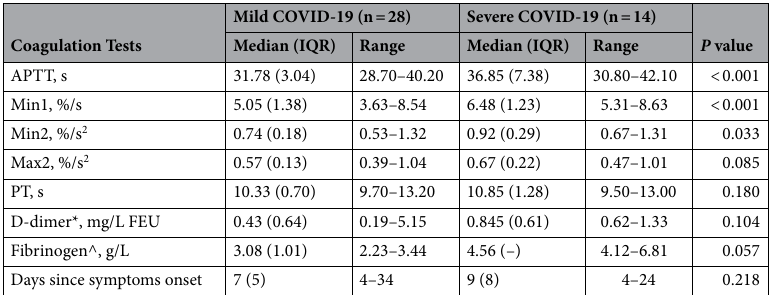
Table 3. Inter-individual comparison of coagulation data (PT, aPTT and aPTT-based clot waveform analysis profiles) between patients with mild COVID-19^ and severe COVID-19 # . * D-dimer results were only available in 11 and 4 patients with mild and severe COVID-19, respectively. ** Fibrinogen results were only available in 4 and 3 patients with mild and severe COVID-19, respectively. ^ Mild COVID-19 defined as patients who did not require supplementary oxygen support throughout the course of infection. # Severe COVID-19 defined as patients who required supplementary oxygen support during course of infection. All data were taken prior to the administration of prophylactic anticoagulant.